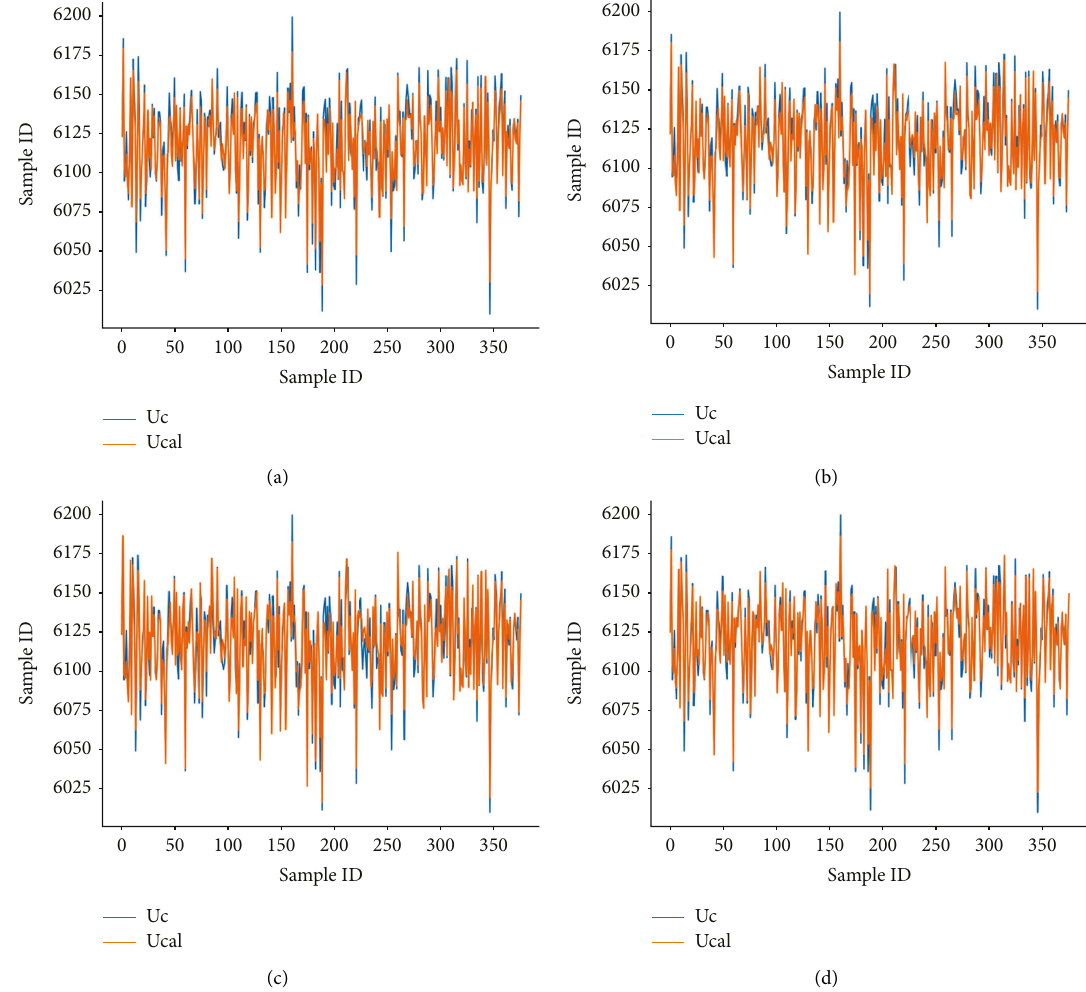
Figure 9: The line plot of U